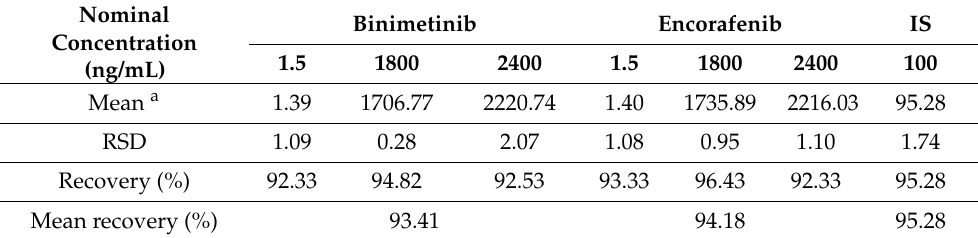
Table 4. Extraction recovery for the analysis of binimetinib and encorafenib and IS in rat plasma by the developed LC-MS/MS